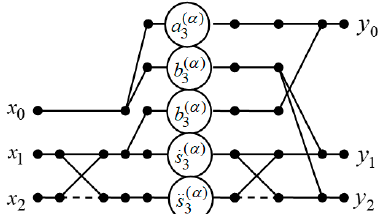
Figure2. Figure 2. The data flow structure of the proposed algorithm for the computation of the three-point DFrFT.